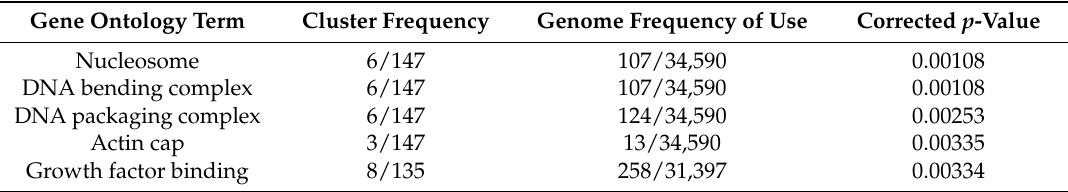
Table 1. Gene ontology (GO) significant functional enrichment ( p < 0.05) analysis of DE lncRNA target genes in activated hHSCs (con) and quiescent hHSCs (VPA).